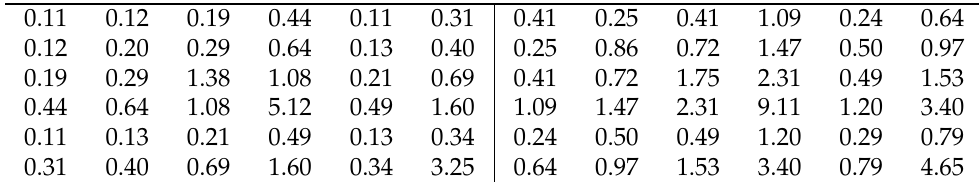
(cid:104) (cid:105) ˆ A ( E , m ) ( 0,1 ) Table 6. σ ( m = 4 left, m = 1 right). These are the elementwise errors of the estimators reported in Table 4. The results above are expressed in 10 − 2